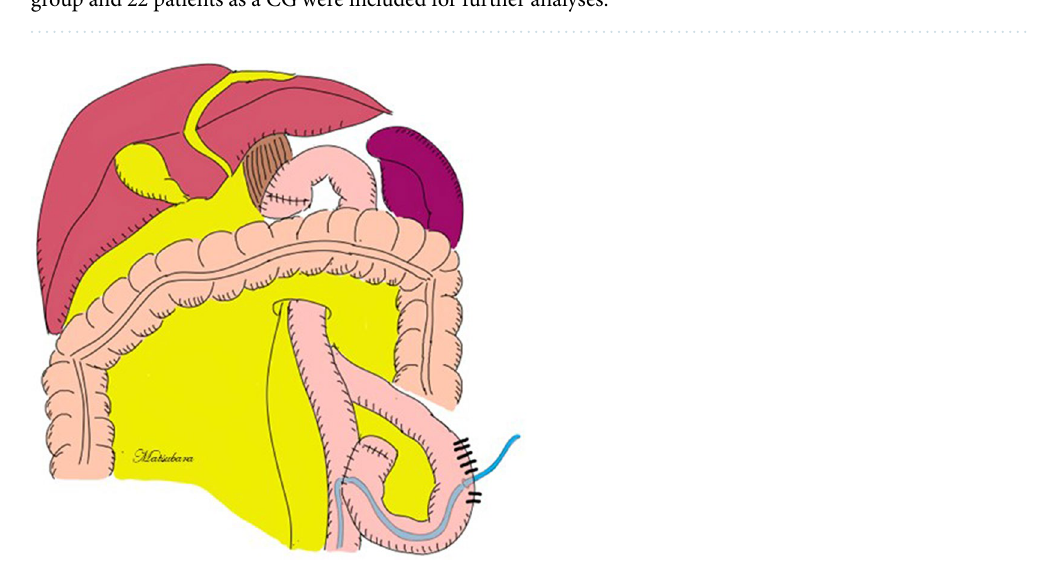
Figure 1. The flow chart of study design and patients’ selection. Between January 1, 2017 and March 31, 2019, 52 consecutive pStage I–III patients underwent curative total gastrectomy with lymphadenectomy. Of these, 14 patients between January 1, 2017 and August 31, 2017 were retrospectively enrolled and did not use night home enteral nutrition (N-HEN), and the remaining 38 patients were prospectively enrolled between September 1, 2017 and March 31, 2019. Of these, 26 patients hoped to use N-HEN and 12 patients refused. As a result, of 52 patients, 26 patients were included as the N-HEN group and 26 patients were included as the control group (CG). In the N-HEN group, one recurrent patient within 6 months and one patient who developed another cancer within 6 months were removed. In CG, two postoperative mortality patients due to acute myocardial infarction and aspiration pneumonia and two recurrent patients were removed. Finally, 24 patients as a N-HEN group and 22 patients as a CG were included for further analyses.